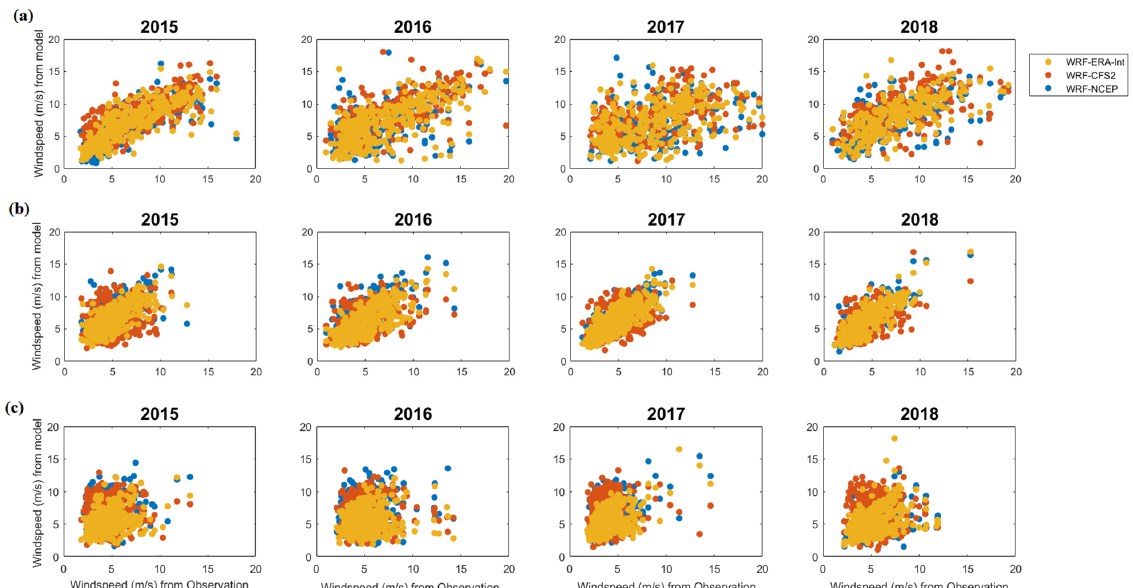
Figure A2. Daily average wind speed in m s − 1 from the models and observations at the offshore locations ( a ) Quanzhou, ( b ) Shanwei, and ( c ) Nansan.